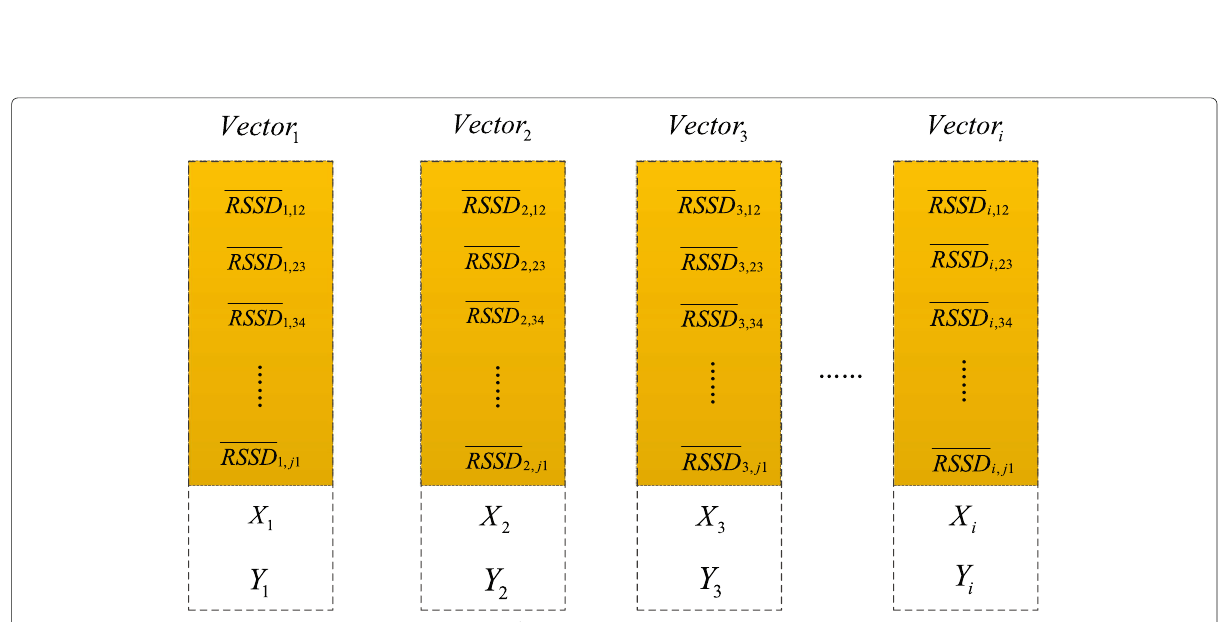
Fig.4 Flowchart of proposed RSSD-based fingerprint database establishment. Take the sampling RSS of i -th reference point from j -th AP for example